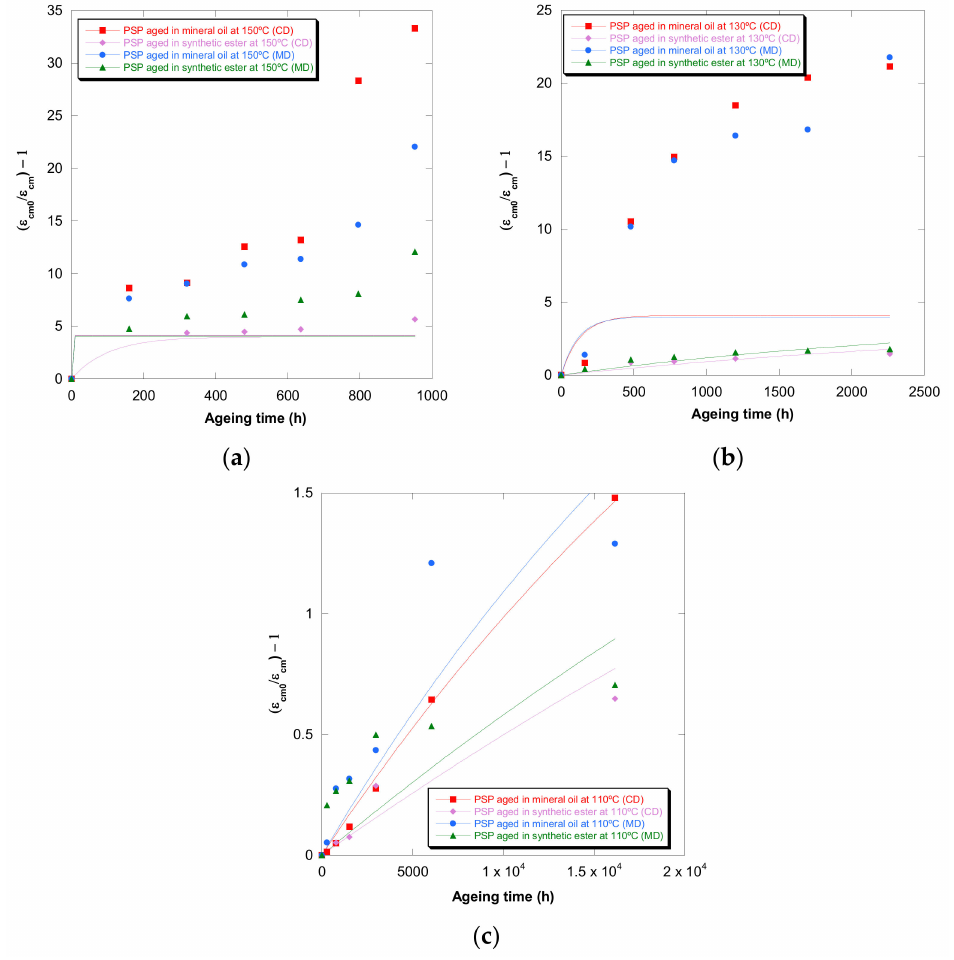
Figure 9. Evolution of the ( ε cm0 / ε cm ) − 1 in MD and CD as a function of temperature for pressboard PSP 3055 aged in mineral oil and in synthetic ester at 150 ◦ C ( a ), 130 ◦ C ( b ), and 110 ◦ C ( c ) and Calvini’s function. Table 7. Constant rates of reaction for the Calvini model based on DP, ε cm, and σ R for different insulation